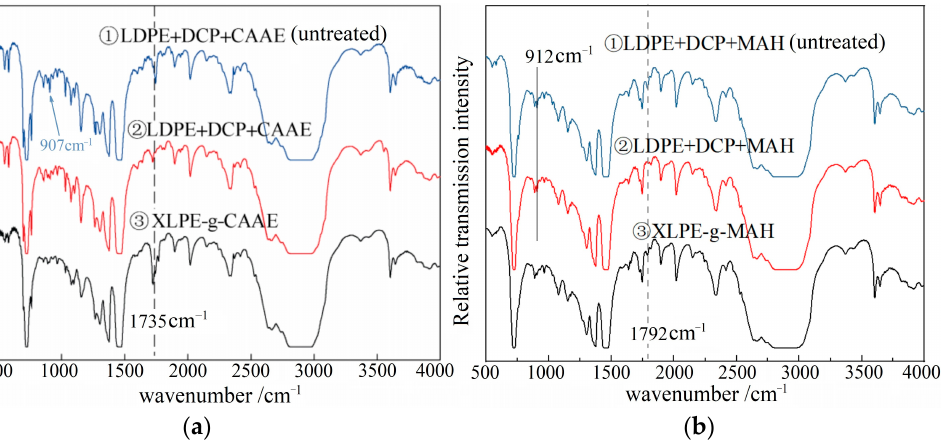
Figure 1. Fourier-transform infrared spectra of uncrosslinked raw material blends before and after vacuum hot-degassing ( ① and ② ) and the modified XLPE ( ③ ): ( a ) grafting 1.0 wt% CAAE and ( b ) grafting 1.0 wt% MAH.